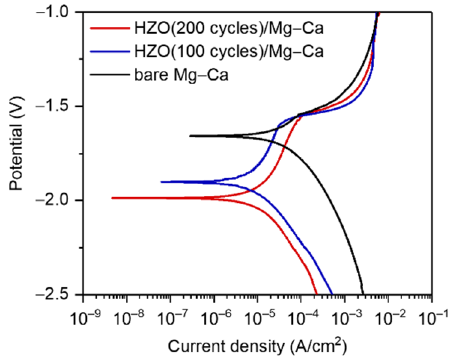
Figure 6. Potentiodynamic polarization curves of bare Mg–Ca alloy and HZO films of 100 and 200 cycles. Table 1. Results of the corrosion current density (i corr ), corrosion potential (E corr ), pitting potential (E pitting ), and the potential difference between E corr and E pitting of PDP curves in Figure 6.